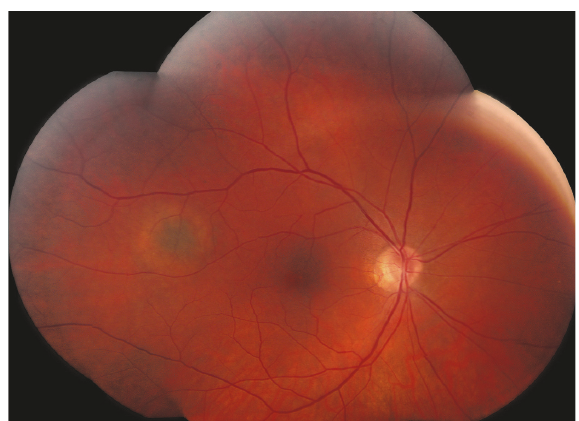
Figure 3: Fundus photography OD shows a temporal halo choroidal nevus.